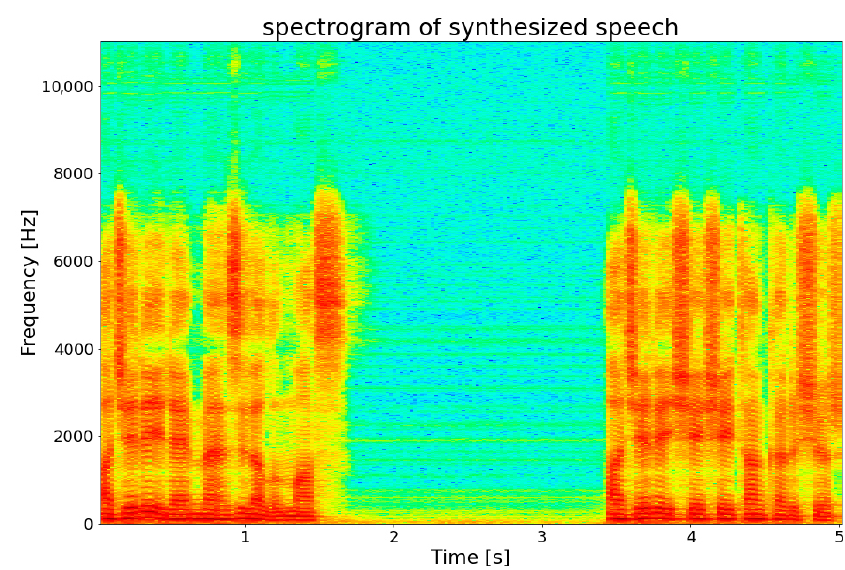
Figure 7. Spectrogram of the synthesized speech recording.